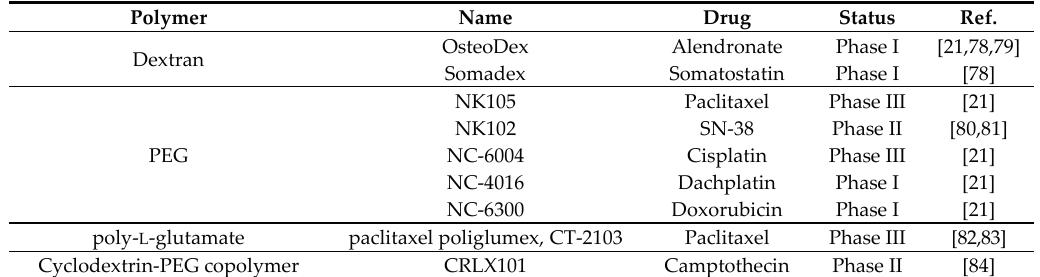
Figure 8. Dextran structure, composed of glucose molecules forming a complex branched glucan chain. Table 2. Current clinical trials of investigational anticancer drugs based on